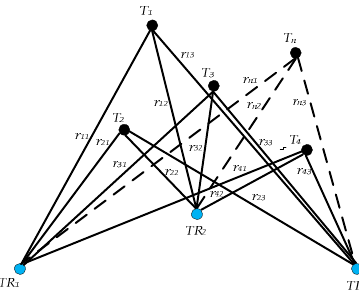
Figure 12. Relative navigation of multiple transceivers.